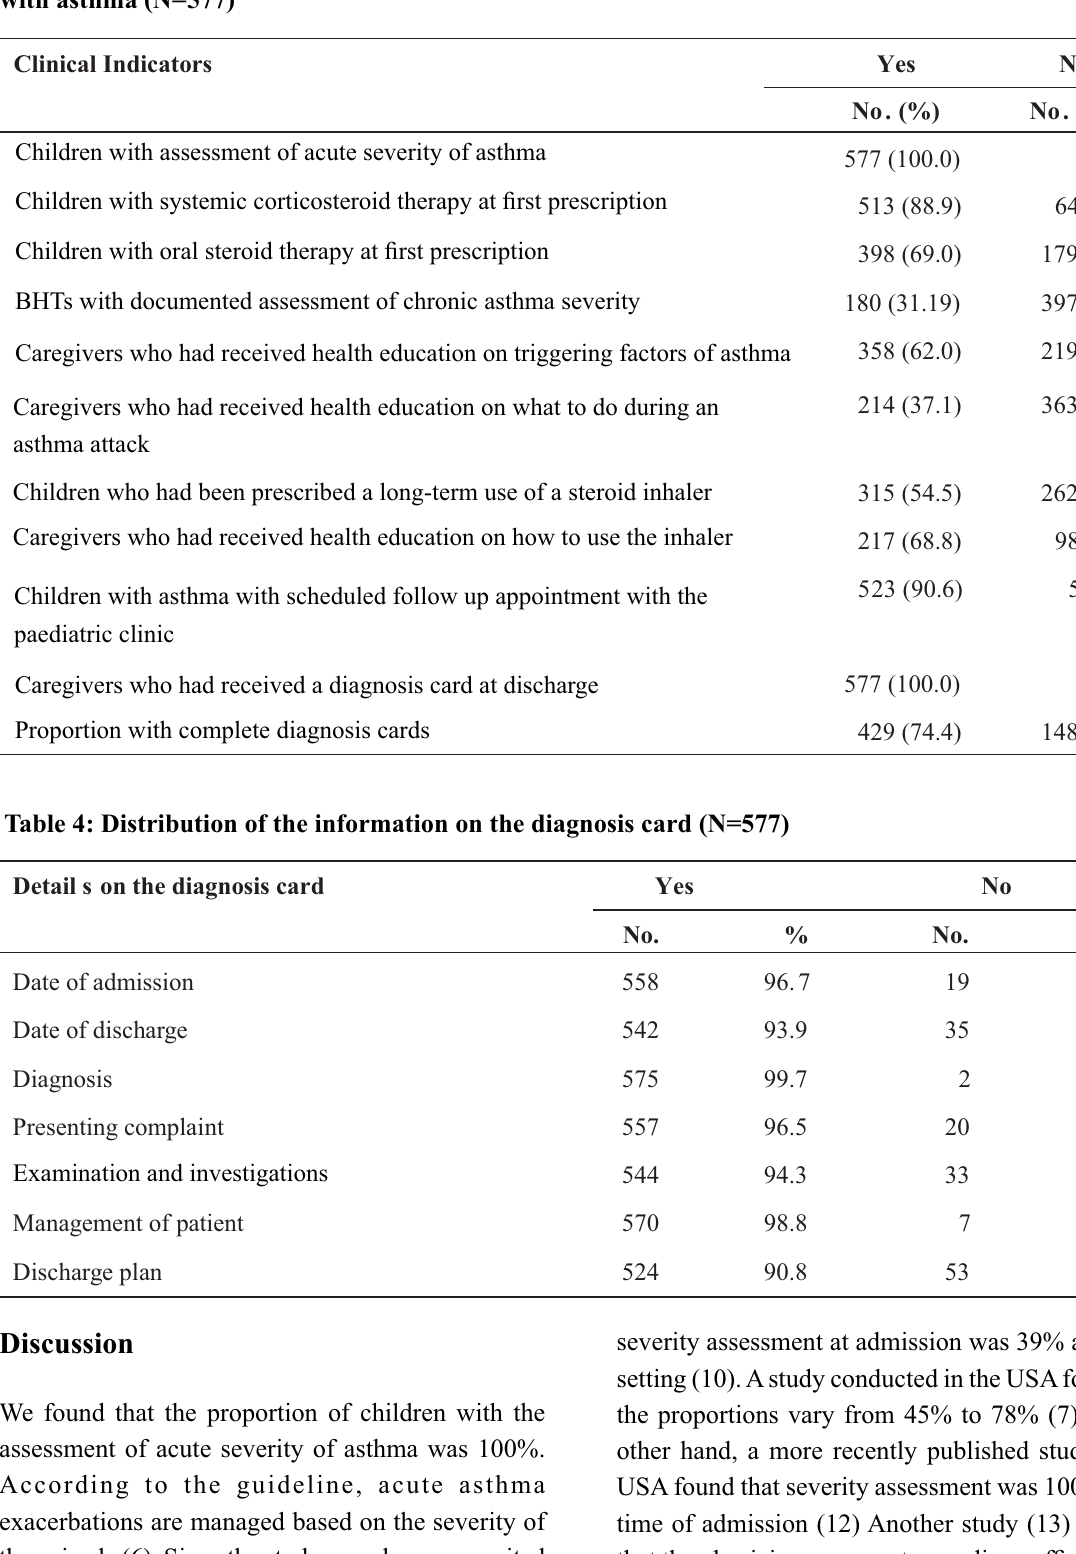
Table 3: Clinical indicators for assessing the quality of management among children with asthma (N=577)